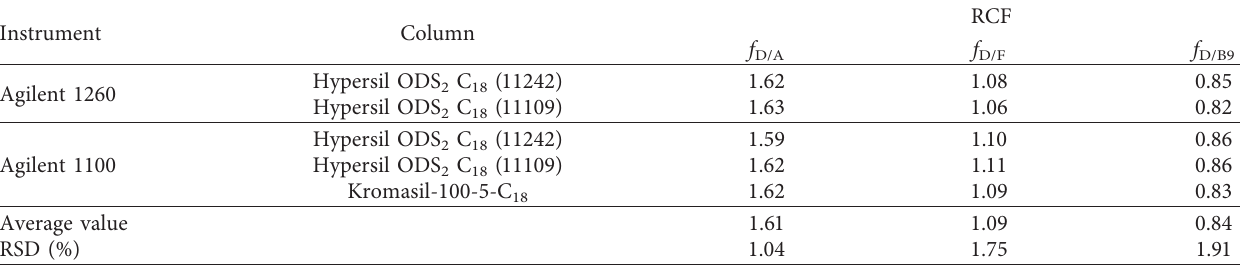
Table 8: The RCF measured by different instruments and columns.